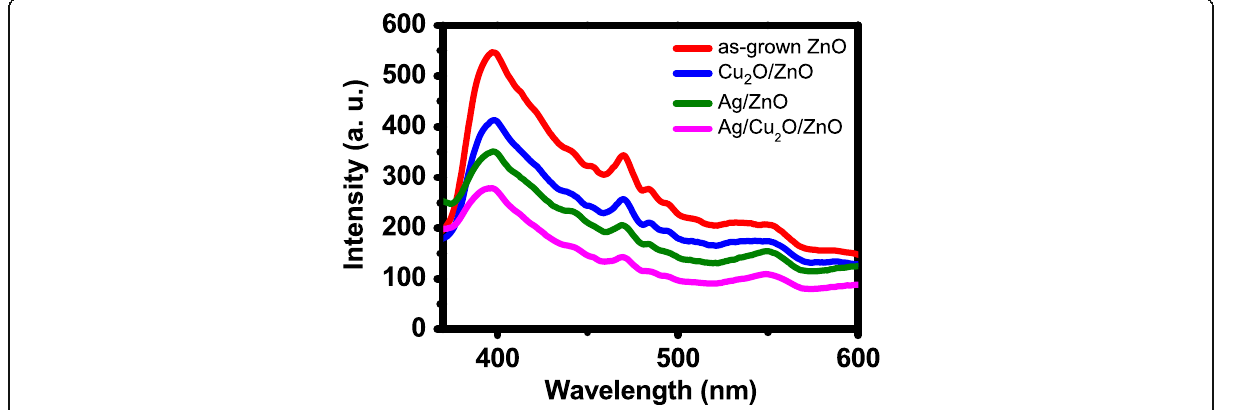
Fig. 6 PL spectra of the four photocatalytic